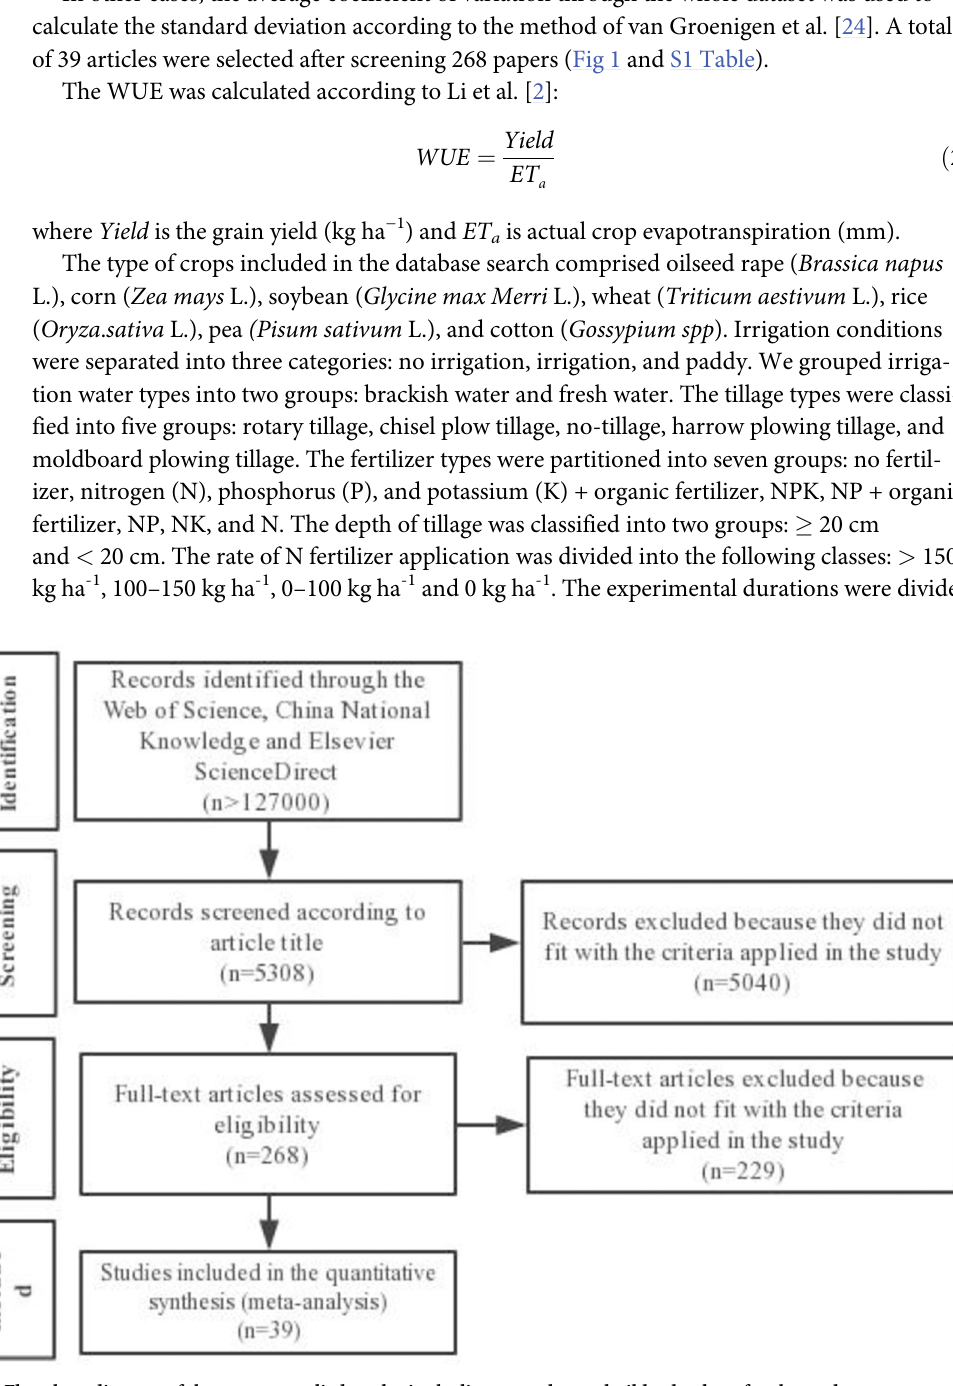
Fig 1. Flowchart diagram of the process applied to obtain the literature data to build a database for the study.